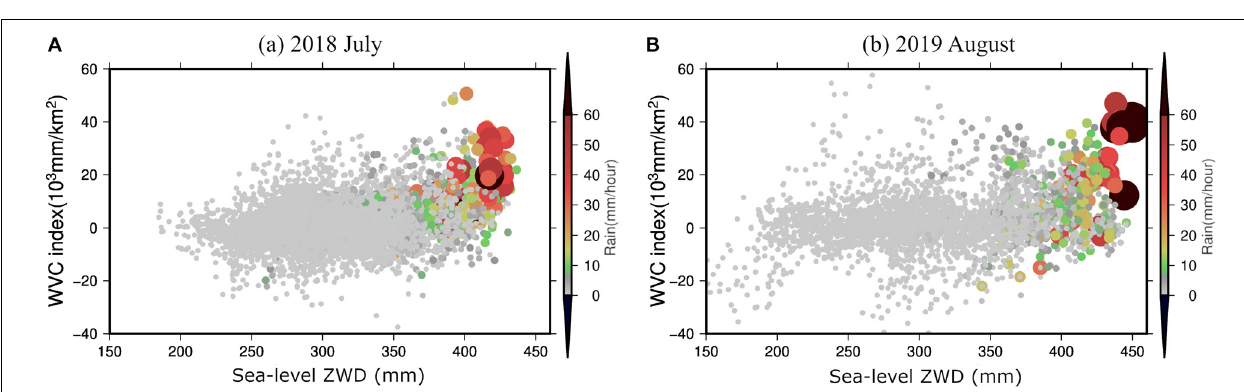
Frontiers in Earth Science |